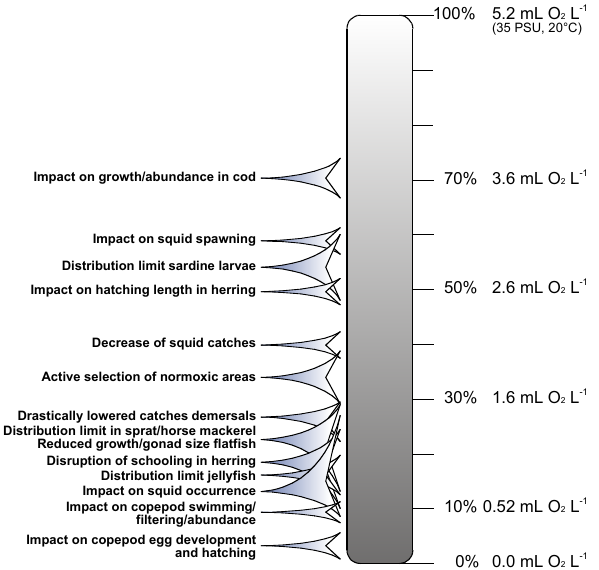
Fig. 3. Behaviour and physiology responses of marine organisms to various oxygen saturation levels. The graph summarizes and illus- trates the information given in Table